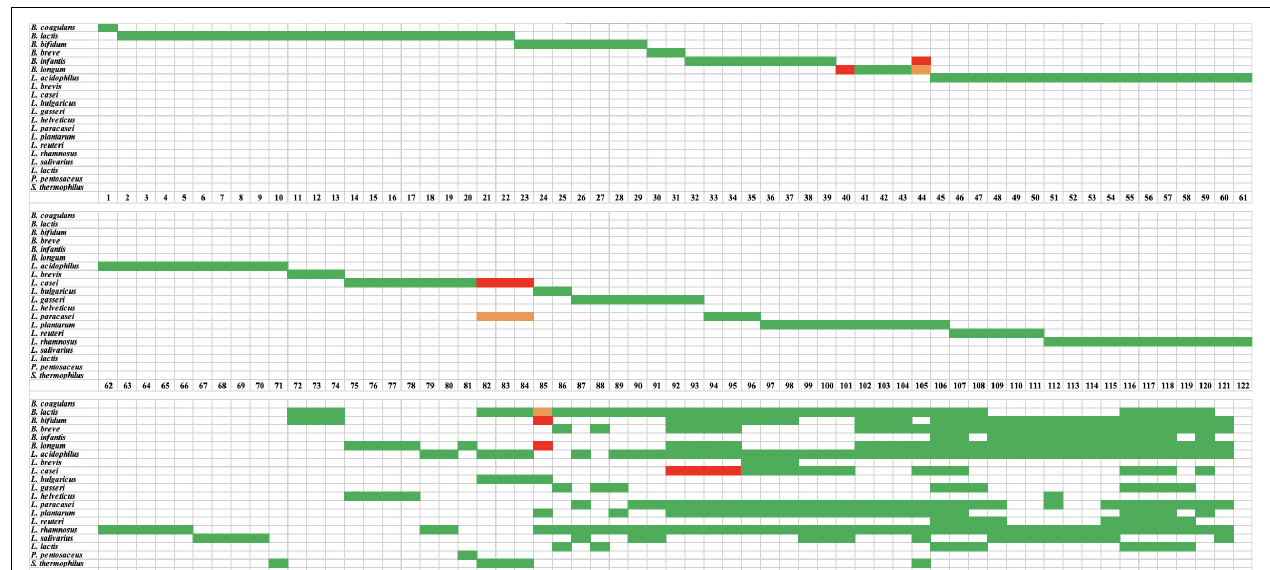
FIGURE 1 | Results of targeted species-specific PCR testing of probiotic samples. Green indicates a species was declared and present. Red indicates a species was declared but absent. Orange indicates that a species was not declared but was